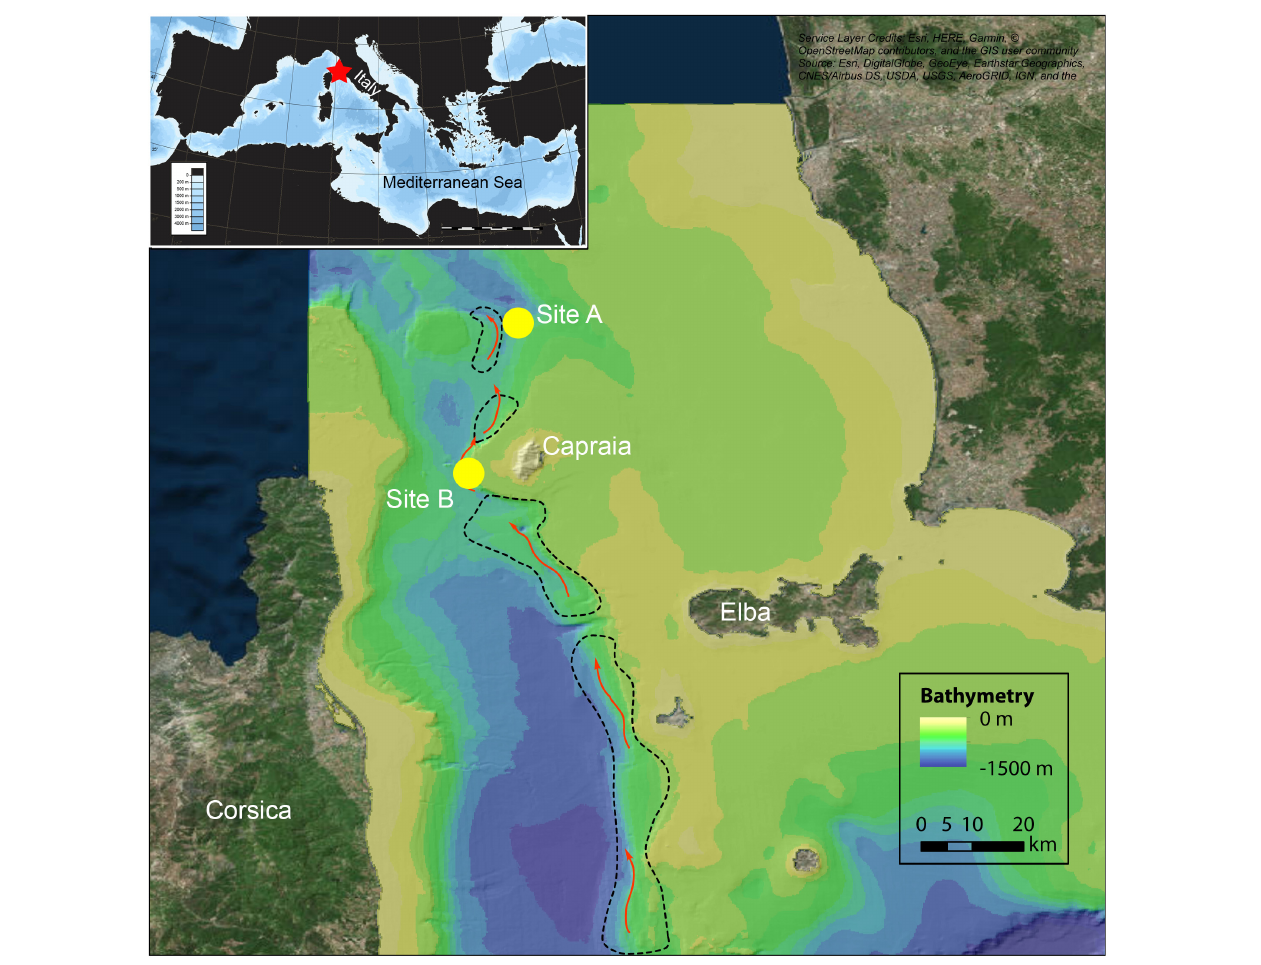
FIGURE 1 | Location map of the Corsica Channel (red star in the inset Basemap data: ESRI ArcGIS) showing the narrowest area of the channel between Corsica Island and the Tuscan Archipelago. Bathymetry from http://www.emodnet-bathymetry.eu/. Dashed line indicates the main contouritic deposits (modified from Miramontes et al., 2016), and red arrows show the main path of the Levantine Intermediate Water. Yellow circles indicate the two explored